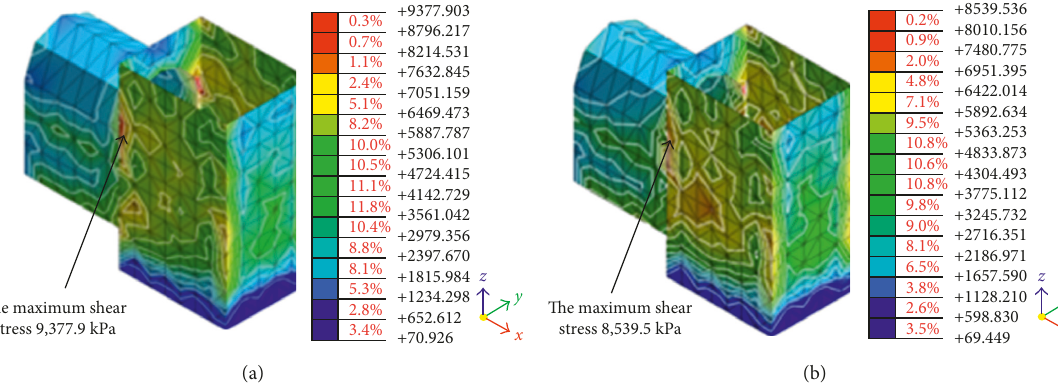
Figure 11: Maximum shear stress distribution in the horsehead. (a) Method 1. (b) Method